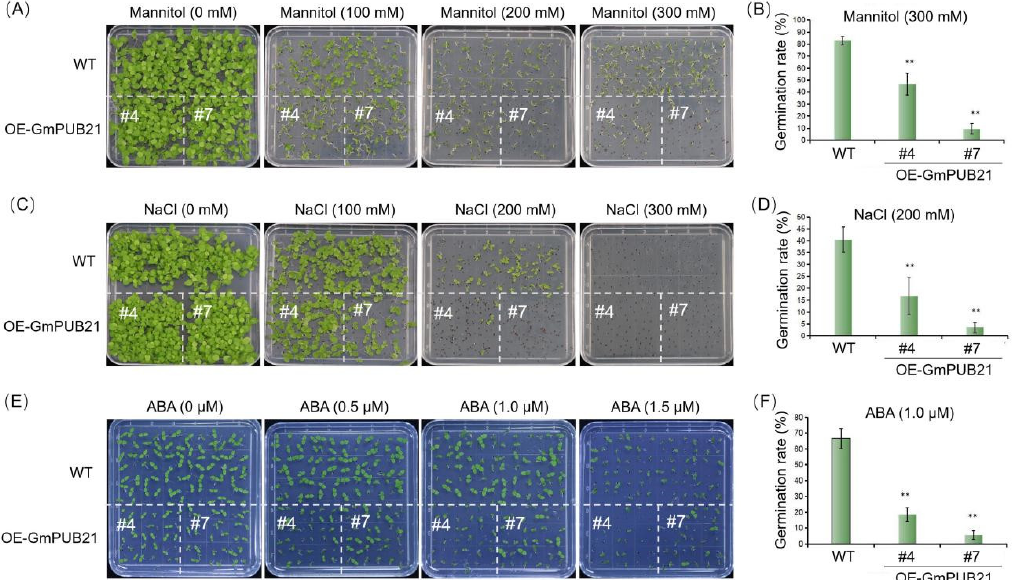
Figure 3. Seed germination of transgenic ( GmPUB21 overexpressing tobacco plants, OE-GmPUB21#4 and OE-GmPUB21#7 ) and wild type (WT) tobacco plants under control and different treatments. Seeds from transgenic and WT plants were grown on the Murashige–Skoog (MS) medium with different concentrations of ( A ) Mannitol (0–300 mM), ( C ) NaCl (0–300 mM) for 12 days and ( E ) ABA (0–1.5 µM) for 8 days. The germination rate of seeds treated with ( B ) 300 mM mannitol, ( D ) 200 mM NaCl for 12days, and ( F ) 1.0 µM ABA for 8 days. For each replicate, more than 30 seeds were measured. The data shown are the means ± SD of three independent experiments. Asterisks indicate statistically significant differences relative to WT (Student’s t -tests, ** p < 0.01).